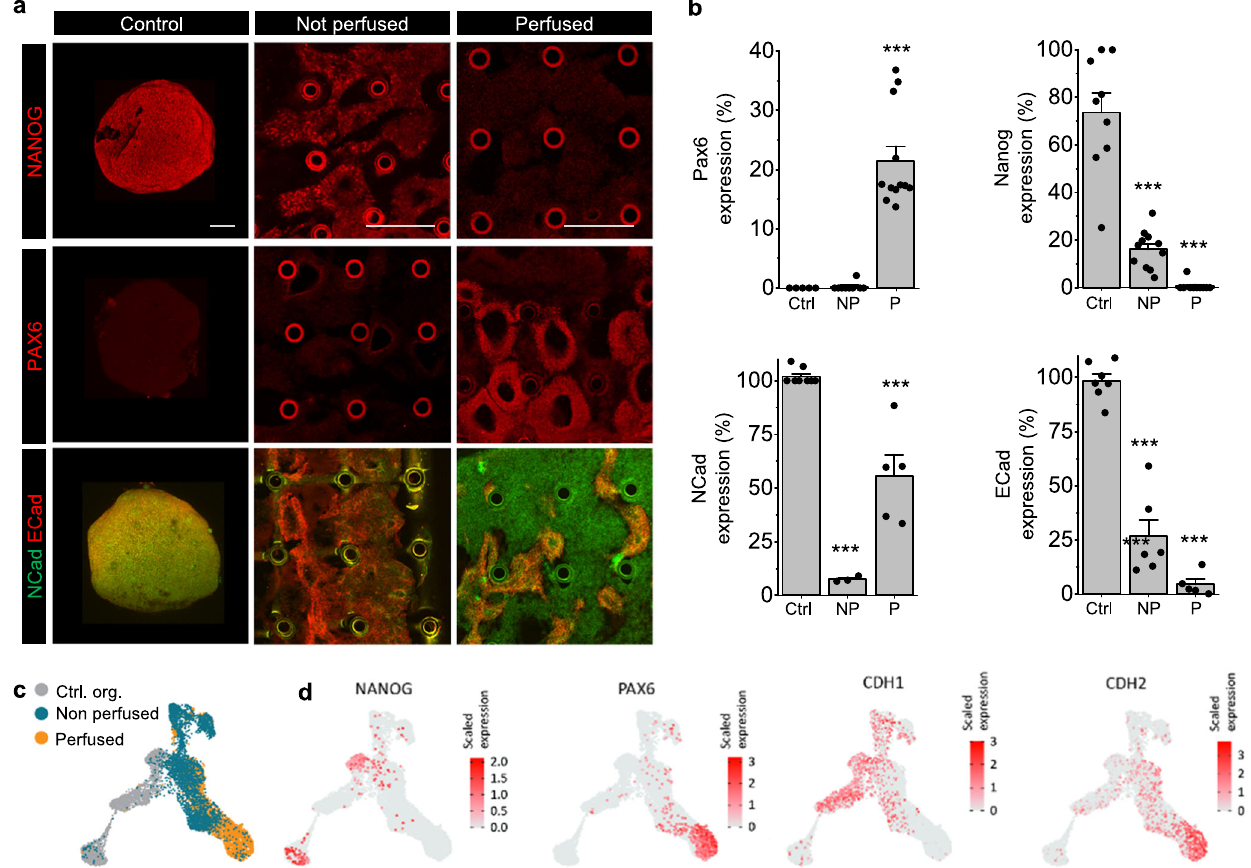
Fig. 4 | Rapid neural differentiation in perfused systems. a Representative experimental results demonstrating the result of 2days of neuronal induction in controlorganoids(leftcolumn),non-perfused(middlecolumn)andperfused(right column) tissue constructs. Top, middle and bottom row: immuno fl uorescent images of stem cell marker NANOG, early neural marker PAX6 and cell adhesion proteinsN-Cadherin(green)andE-Cadherin(red).Theimagesrepresenttransverse cross-sections of the tissue constructs. In most cases, the cross-sections of capil- lariesarevisibleascircularstructures.Statisticsonbiologicalreplicatesaregivenin b . b Average expression of PAX6 (Ctrl: Not detected, n =5; NP: 0.2%±0.2%, p Control =0.35(n.s.), n =9; P: 21.5±2%, p Control =0.00002, n =12), NANOG (Ctrl: 73.6±8%, n =9; NP: 16.1±2%, p Control =0.00007, n =11; P: not detected, n